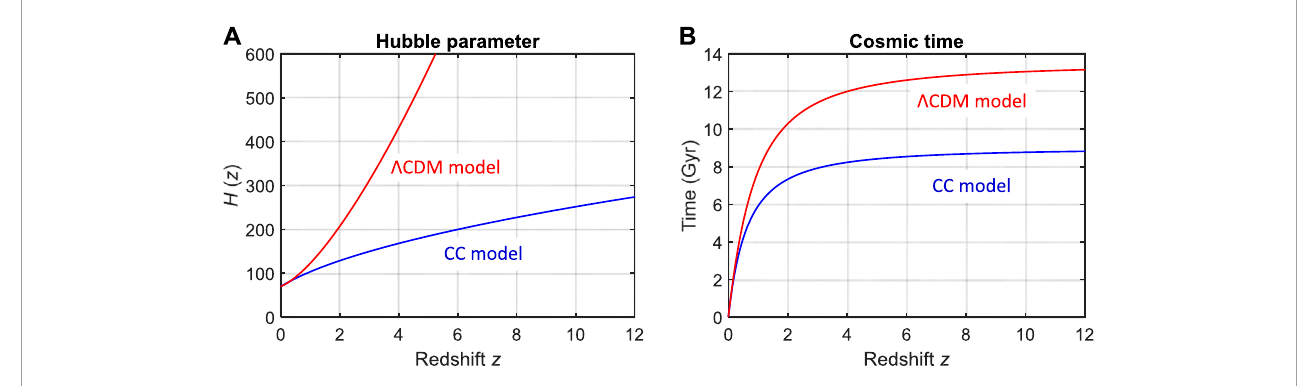
FIGURE 1 The Hubble parameter (A) and the proper cosmic lookback time (B) as a function of redshift. The cosmological model is described by Eq. 17 for the CC metric (blue line) with Ω m = 1 . 2, and Ω k = − 0 . 2 (Vavryčuk, 2022a). The red line shows the standard Λ CDM model. The Hubble constant is H 0 = 69 . 8 km s −1 Mpc −1 , obtained by Freedman et al. (2019) from observations of the SNe Ia data with a red giant calibration. Note that panel (B) does not imply that the age of the Universe is less than about 9 Gyr in the CC model. For redshifts z > 15, the cosmic evolution becomes more complicated due to light-matter interactions, and Eq. 17 must be modified, see Vavryčuk (2022b).